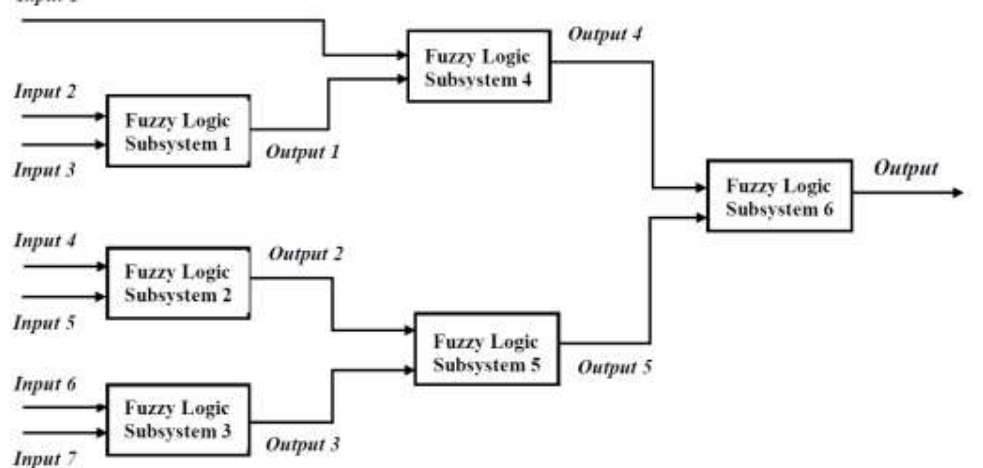
Figure 1. Three-level hierarchical fuzzy logic